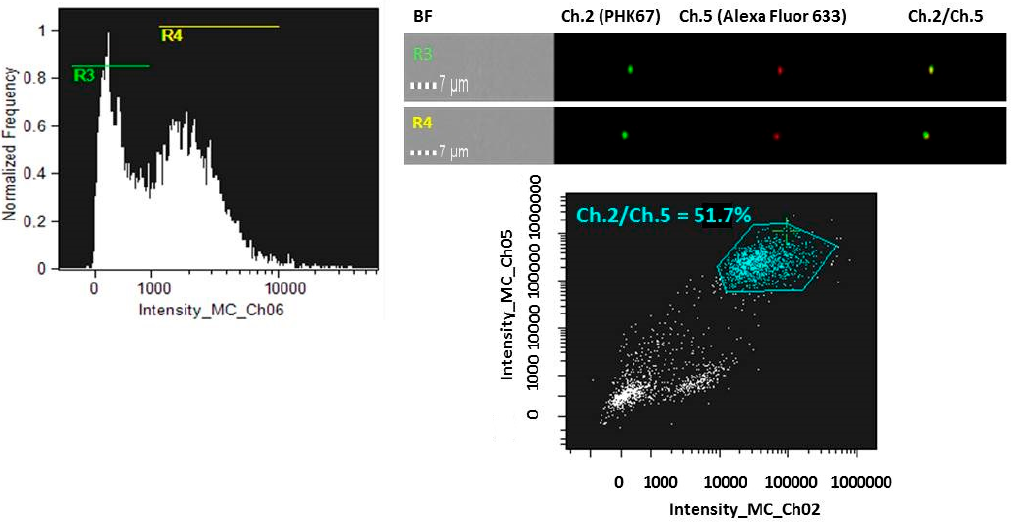
Figure 7. Amnis ImageStreamX MarkII flow cytometry analysis of membranes generated vesicles (M-NVs) stained with green fluorescent PHK67 dye and encapsulated with an Alexa Fluor 633 conjugated secondary antibody, visualized in Brightfield ( BF ), Ch.2 and Ch.5 fluorescent channels, respectively at 60× magnification. For cytometry, a total of 15,000 particles were acquired.